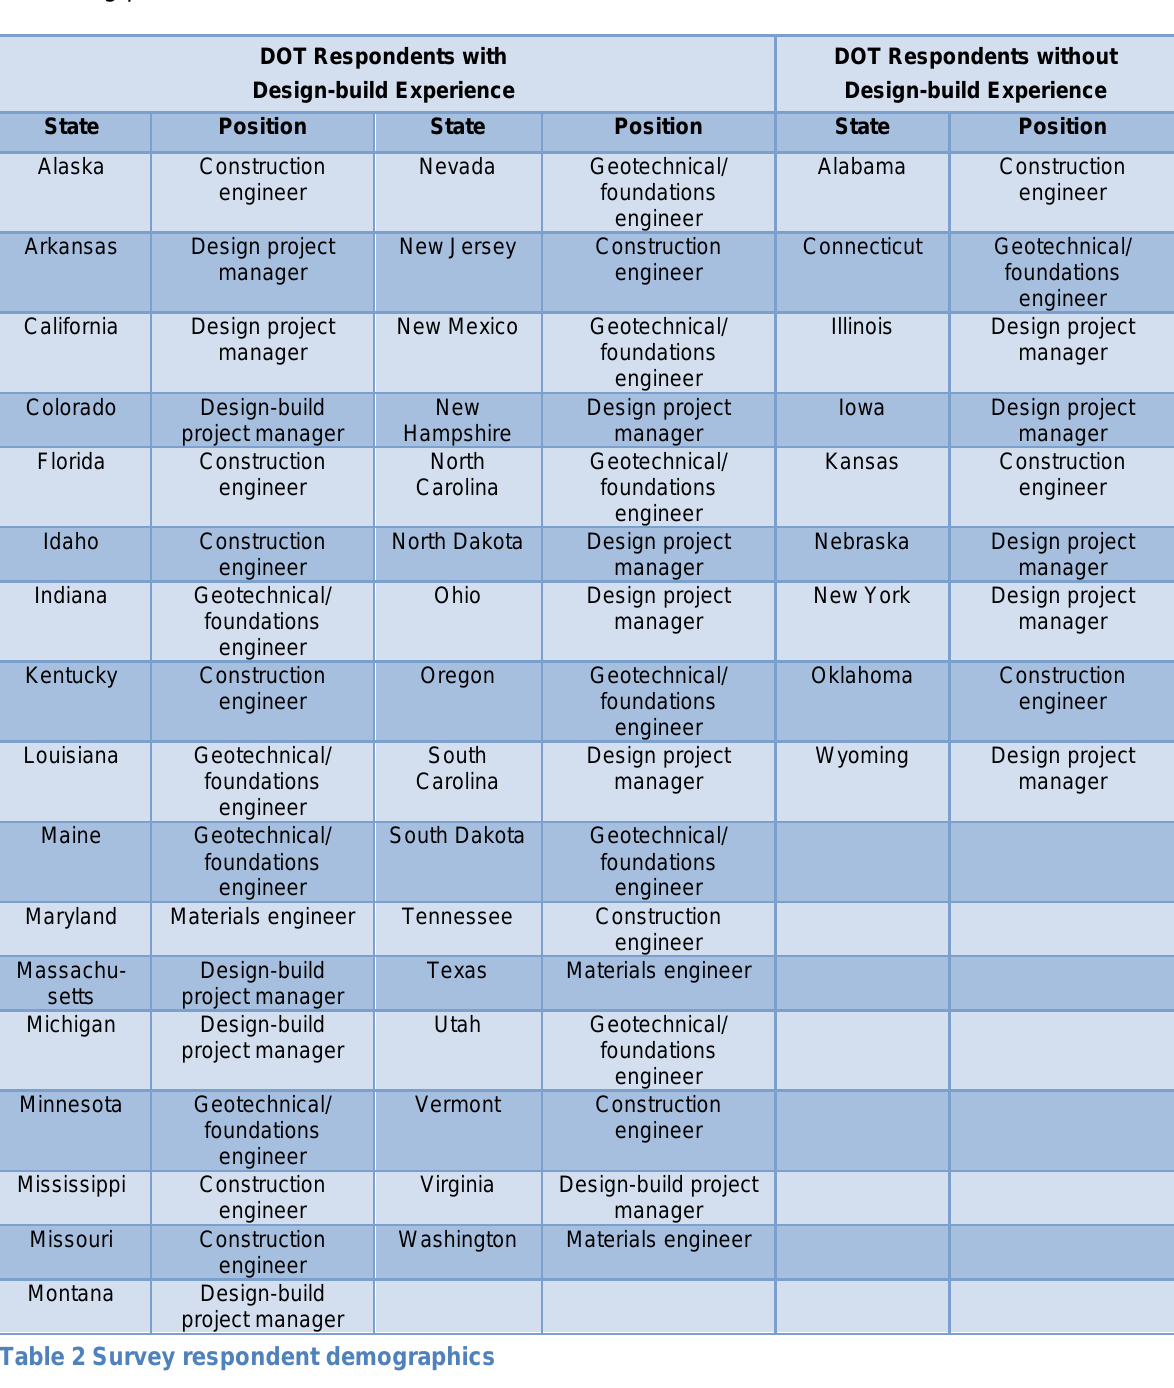
Table 2 Survey respondent